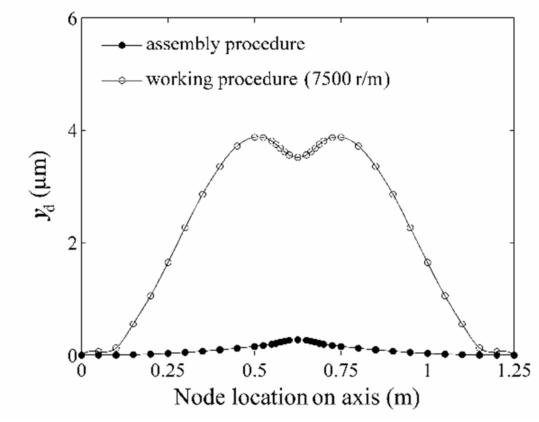
Figure 7. Rotor bending vector y d along every node location on the rotor